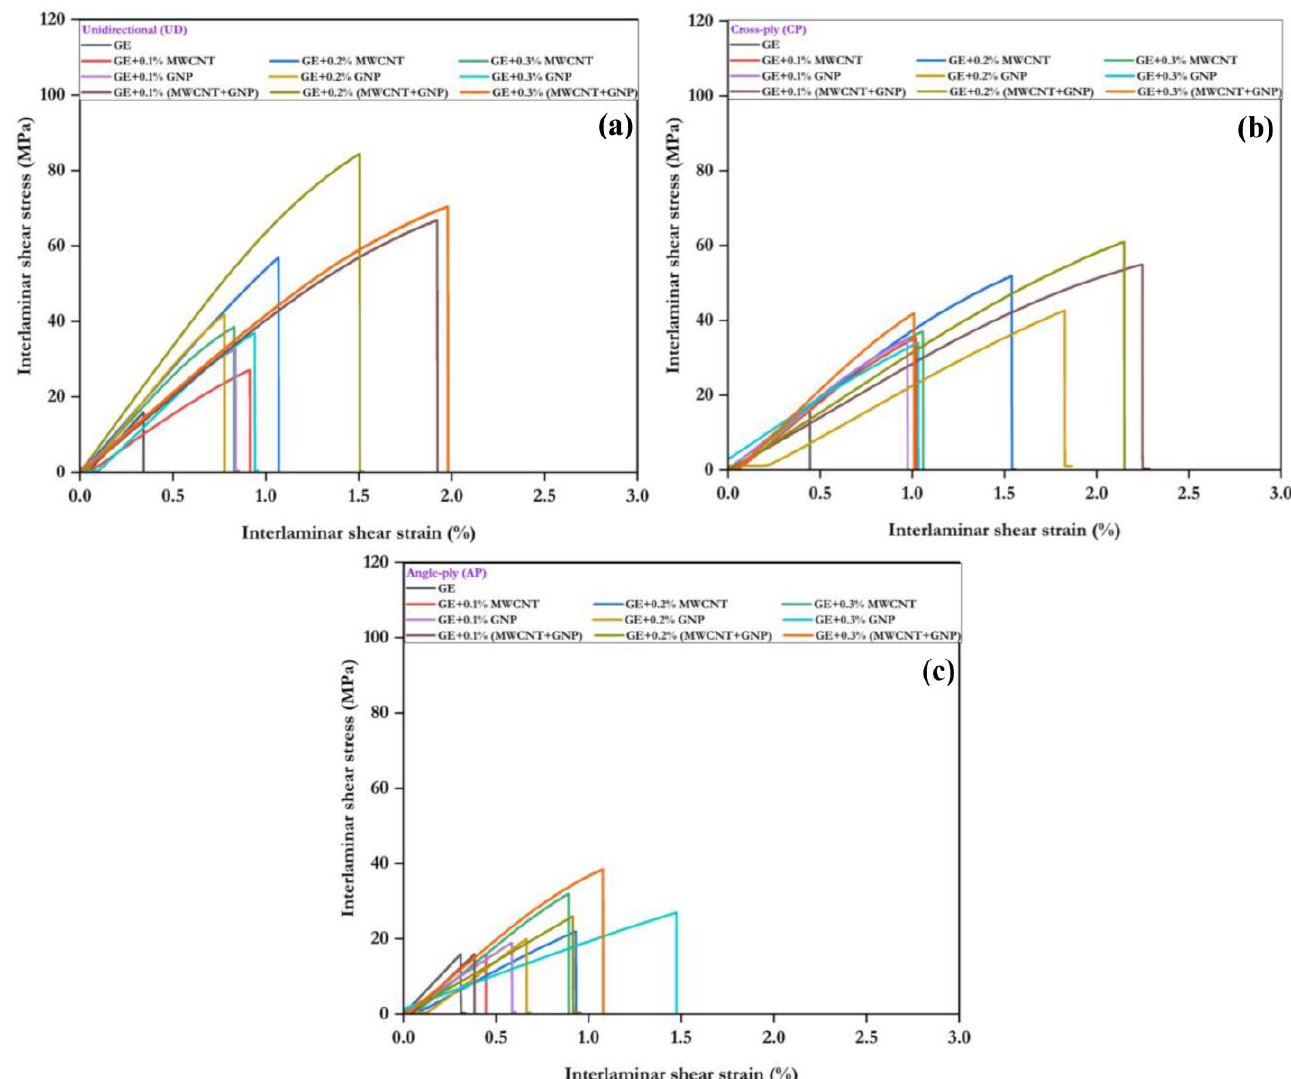
Figure 14. Interlaminar stress – strain response: ( a ) UD, ( b ) CP, and ( c ) AP.